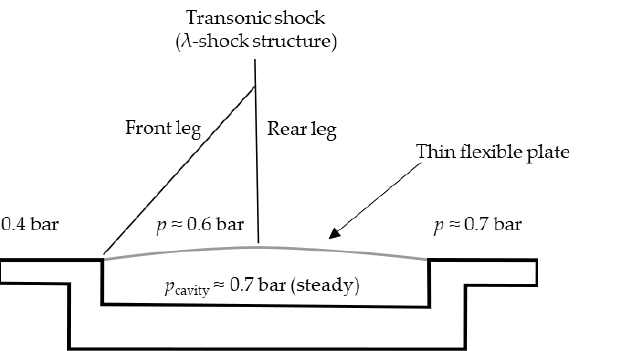
Figure 11. Formation of a lambda-shock structure due to the bump formation of a pressure-deformed flexible plate based on [81].